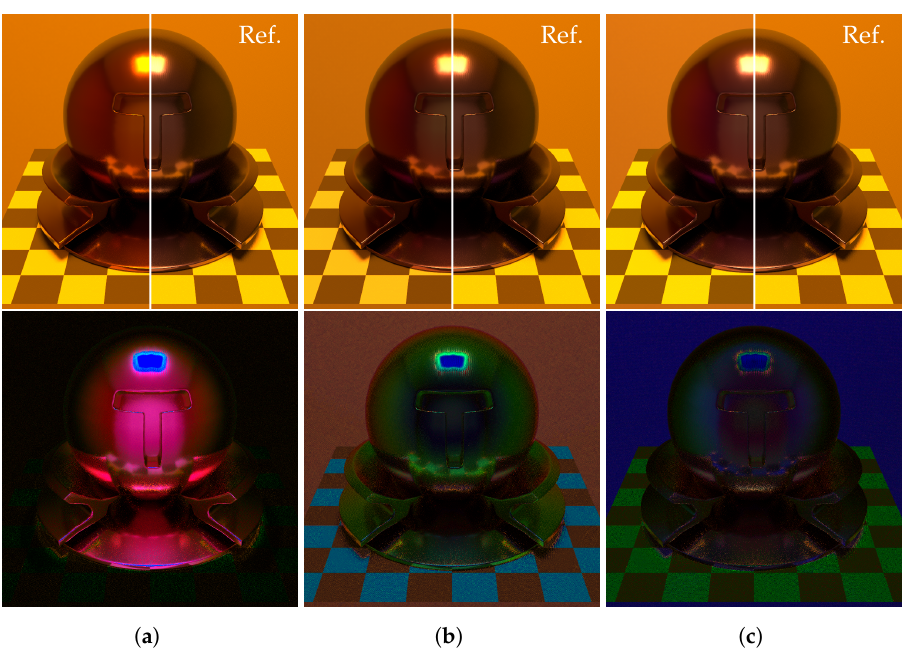
Figure 14. Results of rendering (HP1). ( a ) RGB rendering. ( b ) PBRT renderer. ( c )